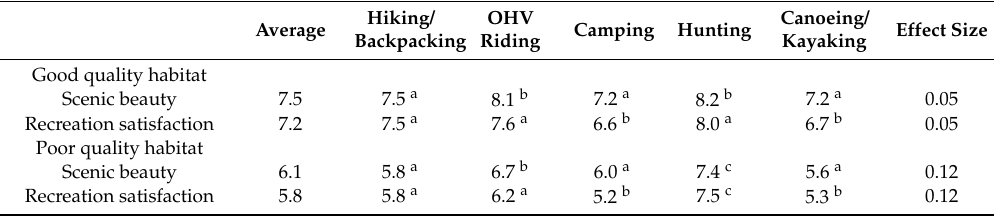
Table 1. Comparison among recreation activity user groups in terms of perceived scenic beauty and recreation satisfaction of good and poor-quality red-cockaded woodpecker habitats in Ocala National Forest, Florida, USA.